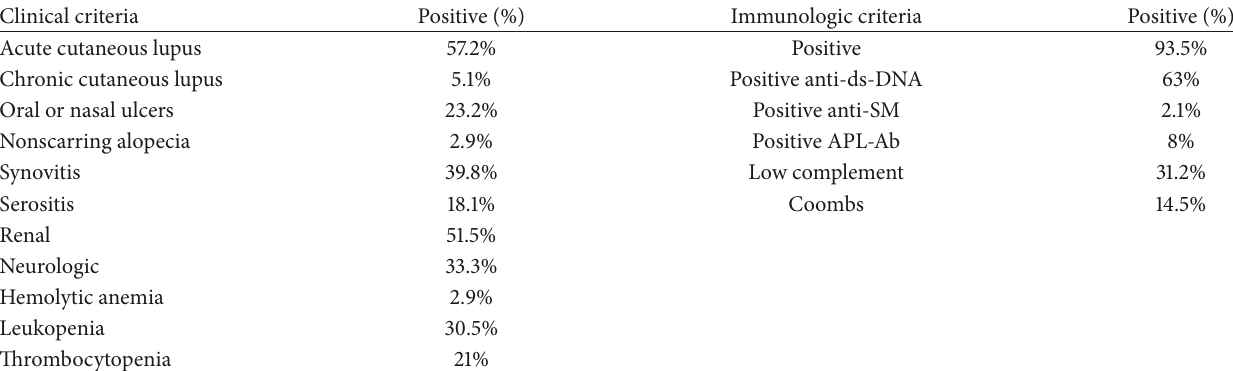
Table 2: Frequency of clinical and immunologic criteria in lupus